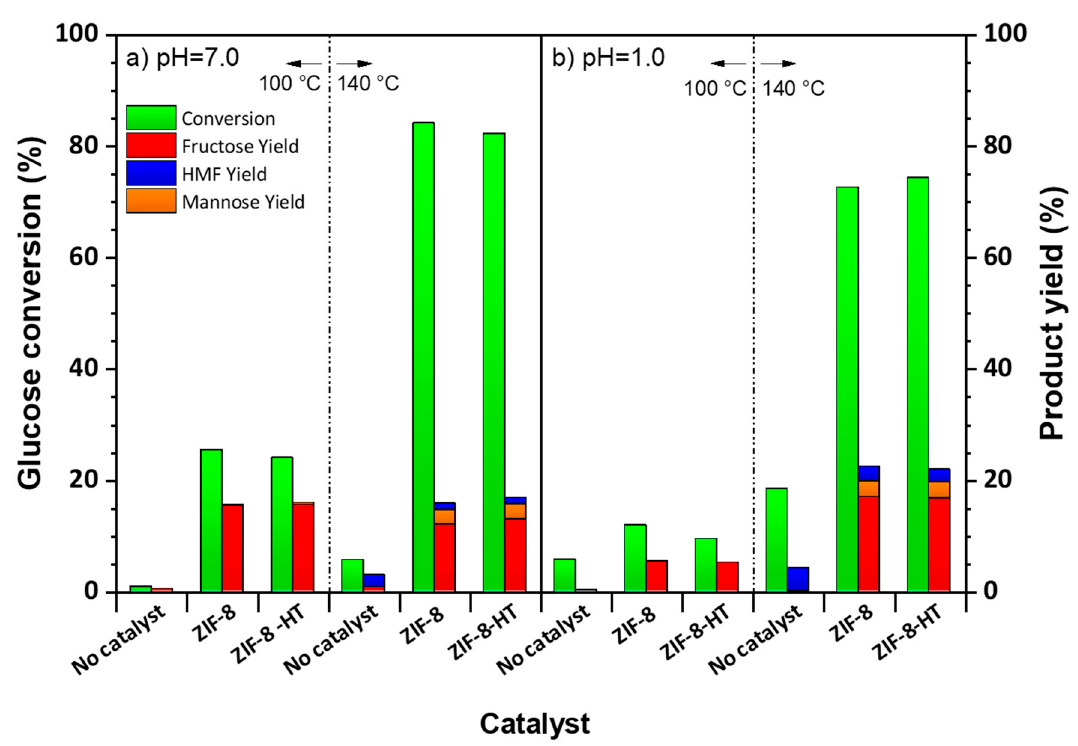
Figure 6. Glucose conversion and product yields at 100 °C and 140 °C in aqueous solutions at ( a ) pH = 7.0 and ( b ) pH = 1.0. Reactions were run in 3 mL batch reactors with 40 mg of catalyst starting with a 10 wt. % glucose in deionized water for 3h. pH = 1.0 corresponds to an aqueous 0.1 M HCl solution.